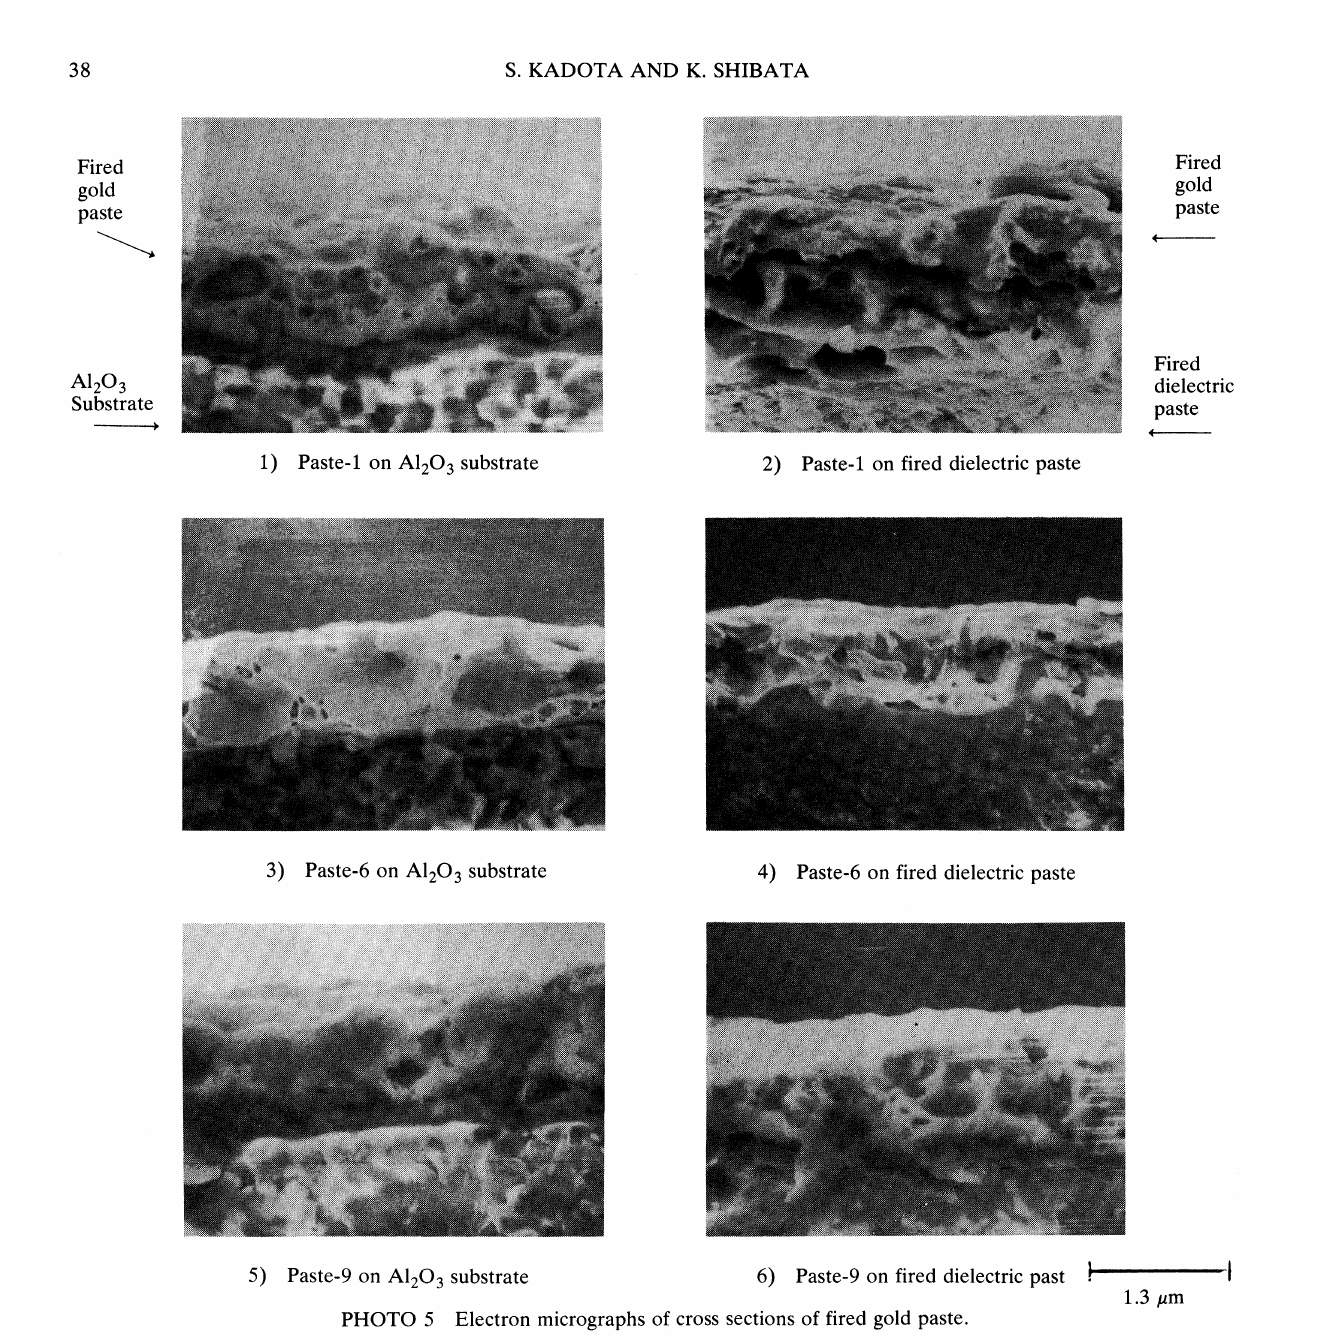
PHOTO 5 Electron micrographs of cross sections of fired gold